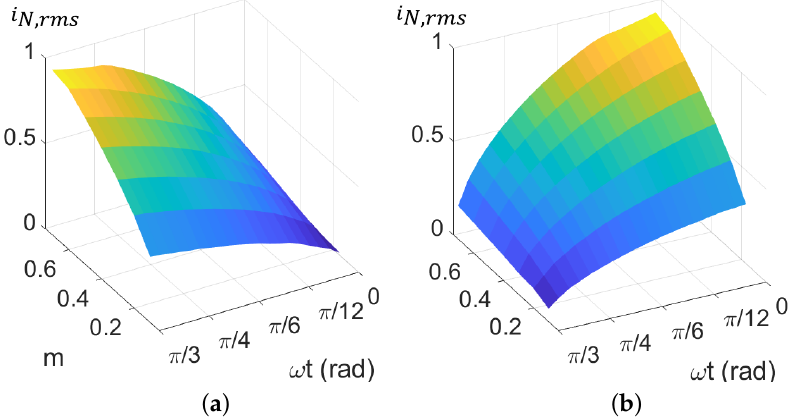
Figure 10. Neutral-point current (rms) in the first Sector for unity power factor when ( a ) u max is reversed, ( b ) u min is